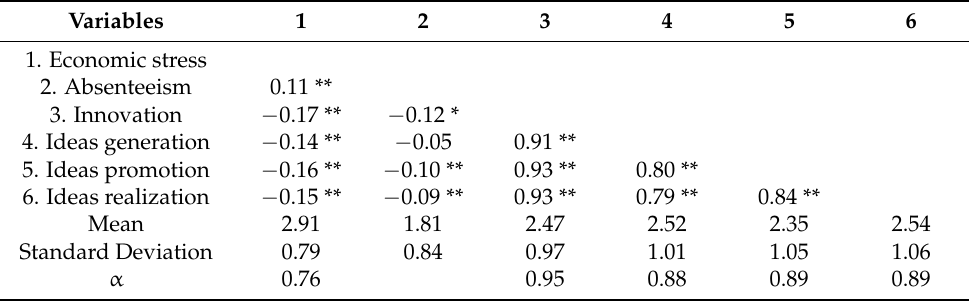
Table 2. Descriptive statistics and correlations between the study